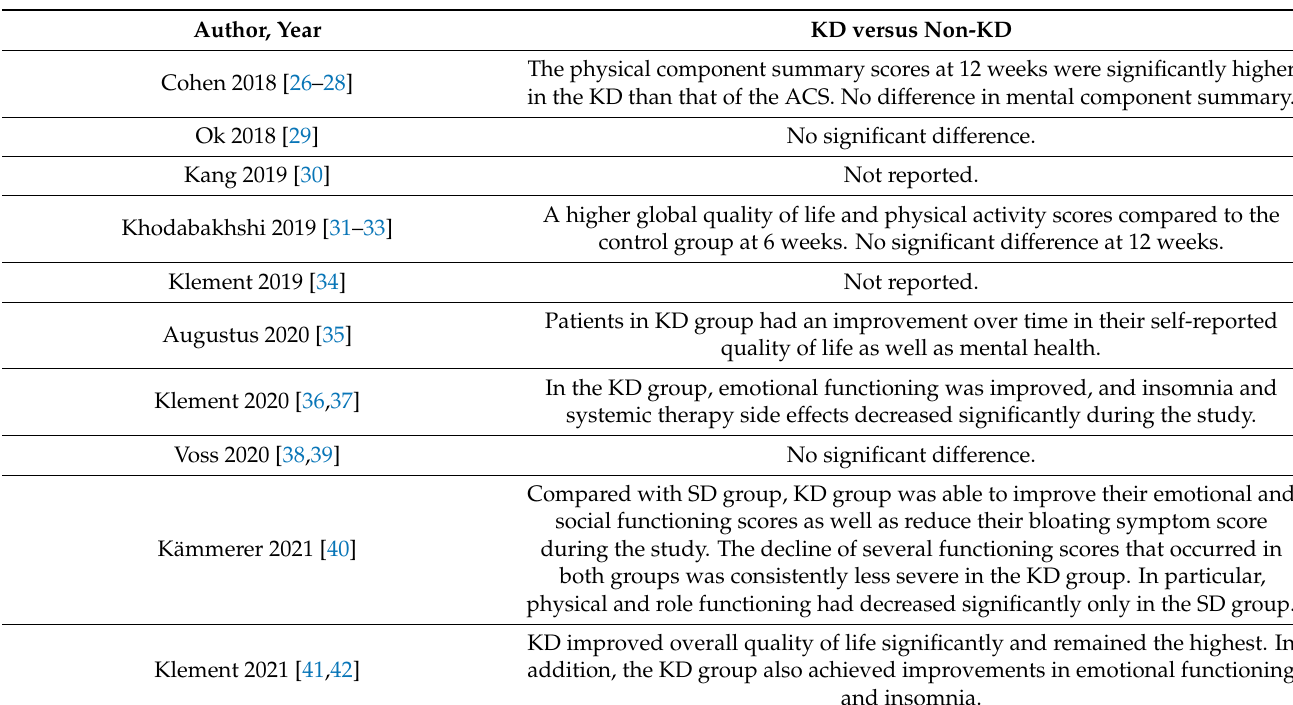
Table 2. Summary of quality of life in